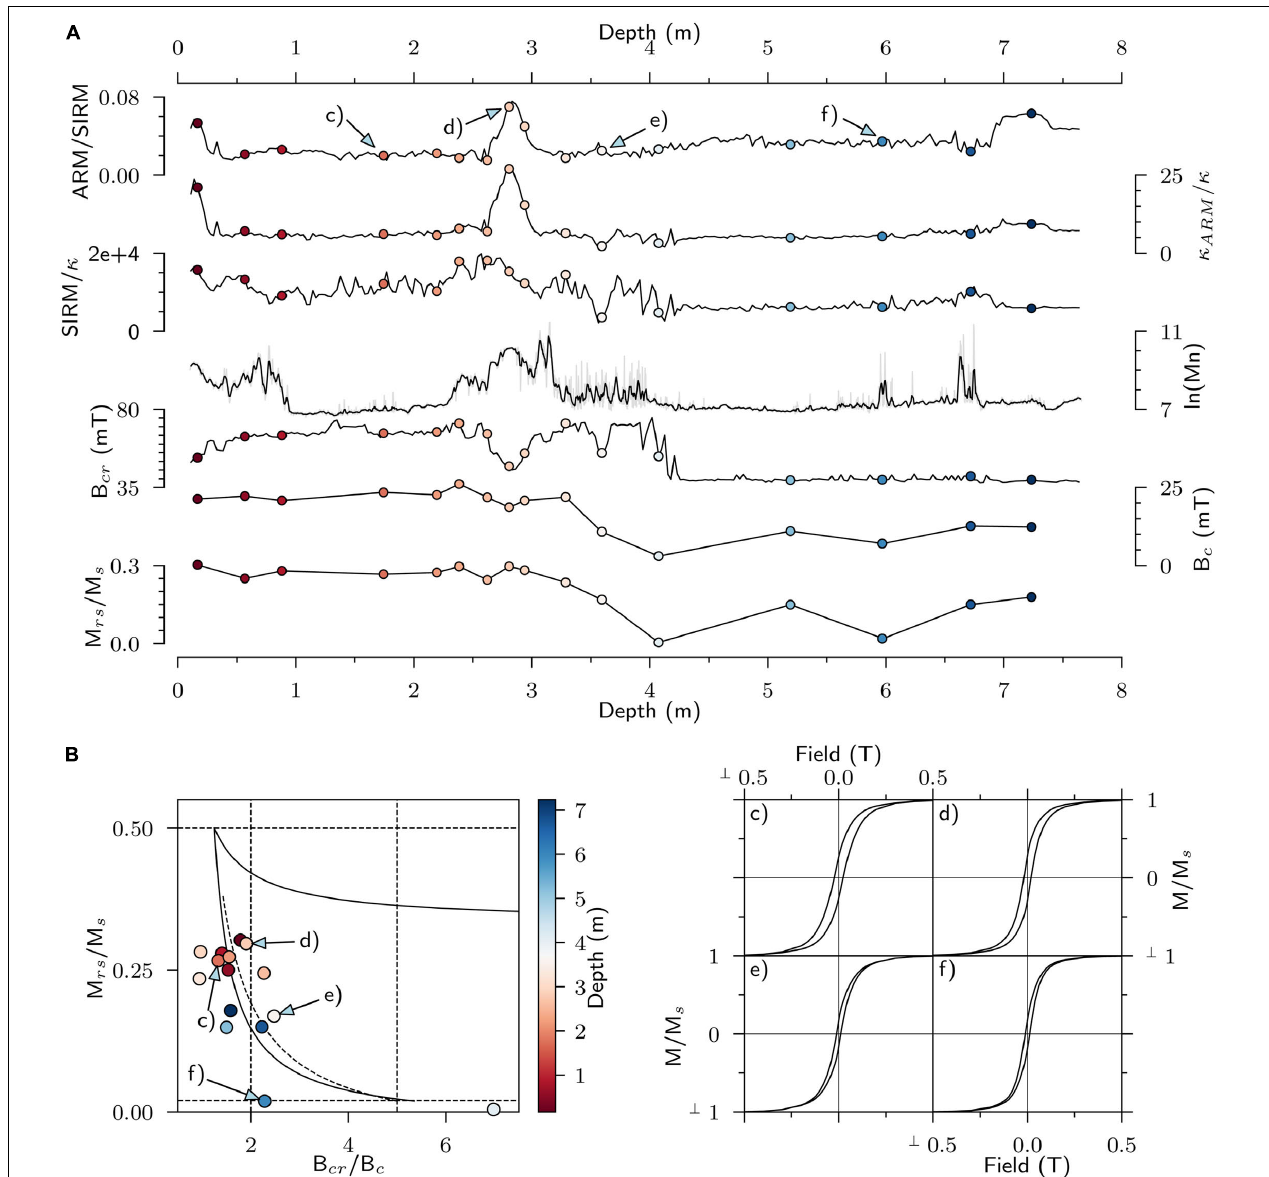
FIGURE 6 | Parameters related to magnetic domain state and mineralogy alongside manganese (Mn) content. (A) Downcore variations of, from top to bottom: ratio of anhysteretic remanent magnetisation (ARM) to saturation isothermal remanent magnetisation (SIRM), ratio of ARM susceptibility ( κ ARM ) to bulk magnetic susceptibility ( κ ), ratio of SIRM to κ , log normalised Mn content (original: grey line; 10-point moving average: black line), coercivity of remanence (B cr ), coercivity (B c ), ratio of saturation remanence (M rs ) to saturation magnetisation (M s ). Points show positions of samples that were subjected to hysteresis measurements, coloured by depth (see colour bar in B ); (B) results from hysteresis measurements, coloured by depth; (c–f) hysteresis loops from 4 selected samples [positions are marked in (A,B) ], slope corrected and cropped to between –0.5 and 0.5